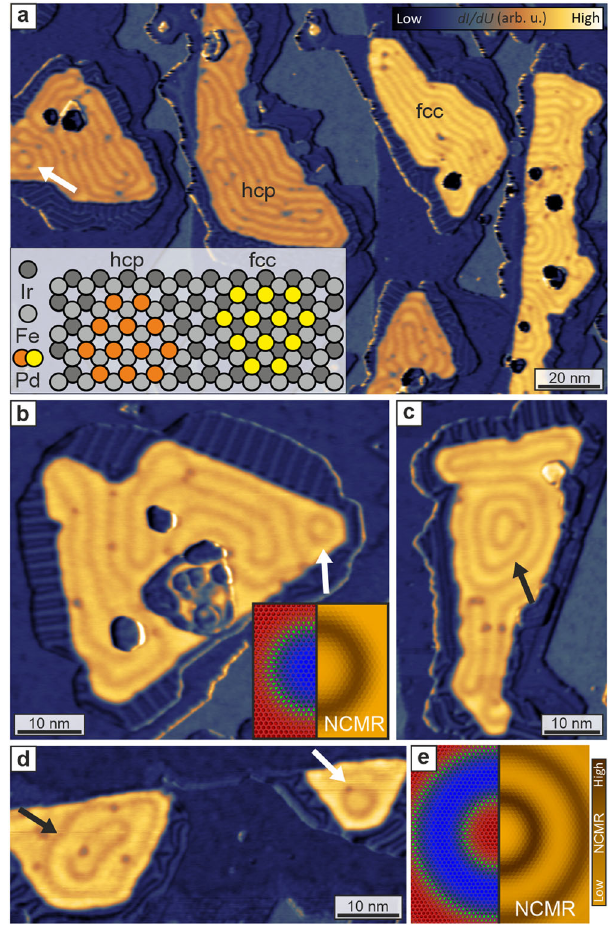
Fig. 2 Skyrmions and target states in the magnetic virgin state. a Spin spirals in hcp-stacked (orange) and fcc-stacked (yellow) Pd/Fe islands are affected by the Co/Fe rim in a similar fashion; the inset shows a sketch of the two possible stacking orders. b Pd/Fe island with a zero- fi eld skyrmion (white arrow) in a corner; the inset shows the spin structure and the expected non-collinear magnetoresistance (NCMR) contrast of a skyrmion. In the spin structure red and blue areas represent opposite out-of-plane directions, in-plane oriented spins are depicted as green cones. c Magnetic target state (black arrow), almost fully encircled by a third ring. d Target state and zero- fi eld skyrmion con fi ned inside relatively small Pd/Fe islands. e Spin structure of a magnetic target state and the corresponding NCMR contrast. All differential conductance (d I /d U ) maps: tunneling current I = 3 nA, bias voltage U = 710